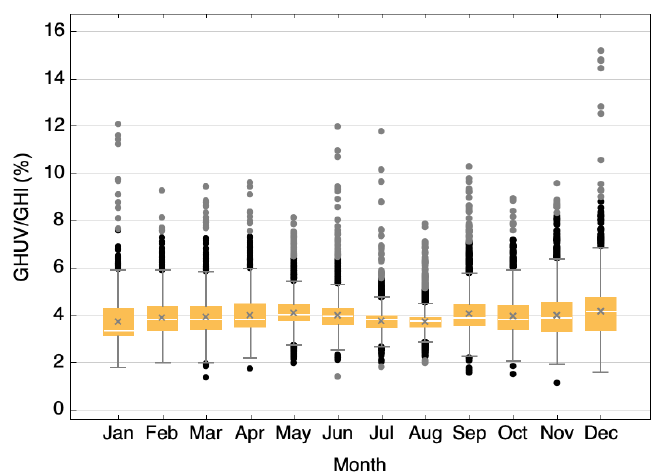
Figure 7. Boxplot of the GHUV/GHI monthly averages based on 10 min datasets.